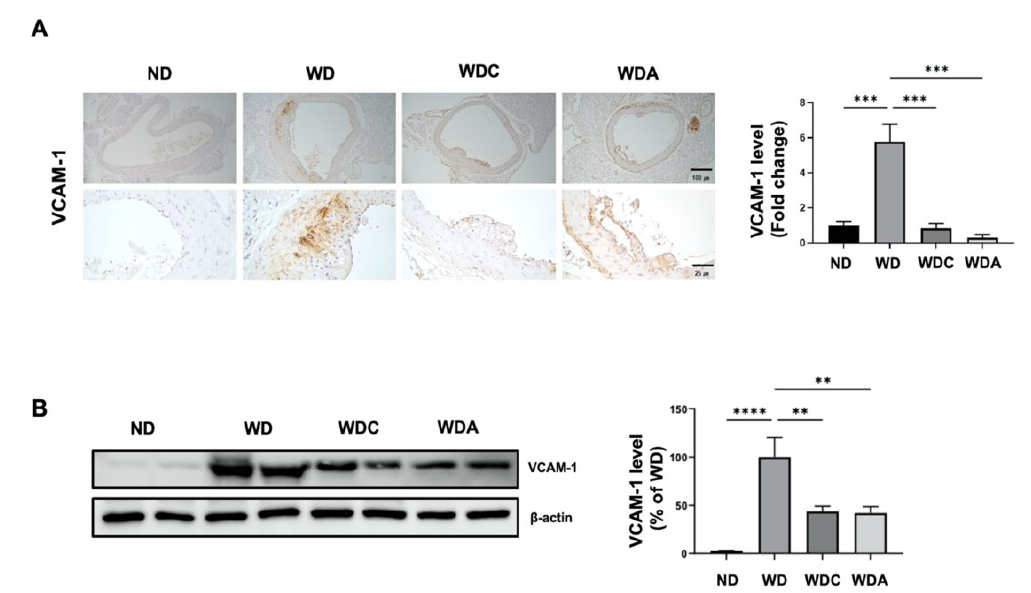
Figure 3. Capsanthin inhibited vascular inflammation in the aorta of Western-type diet (WD)-fed ApoE − / − mice. ( A ) Photography of immunohistochemistry for VCAM-1 expression in the aortas of each group. VCAM-1 was developed with a brown color in the aortas of each group and counterstained with purple color (left). Representative immunohistochemistry images indicate × 10 magnification (upper, scale bar, 100 μ m) and ×40 magnification (bottom, scale bar, 25 μ m). Fold changes in the levels of VCAM-1 expression relative to those of the WD group are shown for each group (right). All values represent the mean ± SEM (n = 3). ** p < 0.01, *** p < 0.001 vs. WD group. ( B ) Immunoblotting for VCAM-1 expression using aortic-tissue lysates obtained from each experimental group (left). Relative band intensities were normalized to that of β -actin. Bar graphs represent the quantitative difference in VCAM-1 expression (right). All values represent the means ± SEM ( n = 4). ** p < 0.01, *** p < 0.001, **** p < 0.0001 vs. WD group. ND: normal diet, WD: Western-type diet, WDC: capsanthin